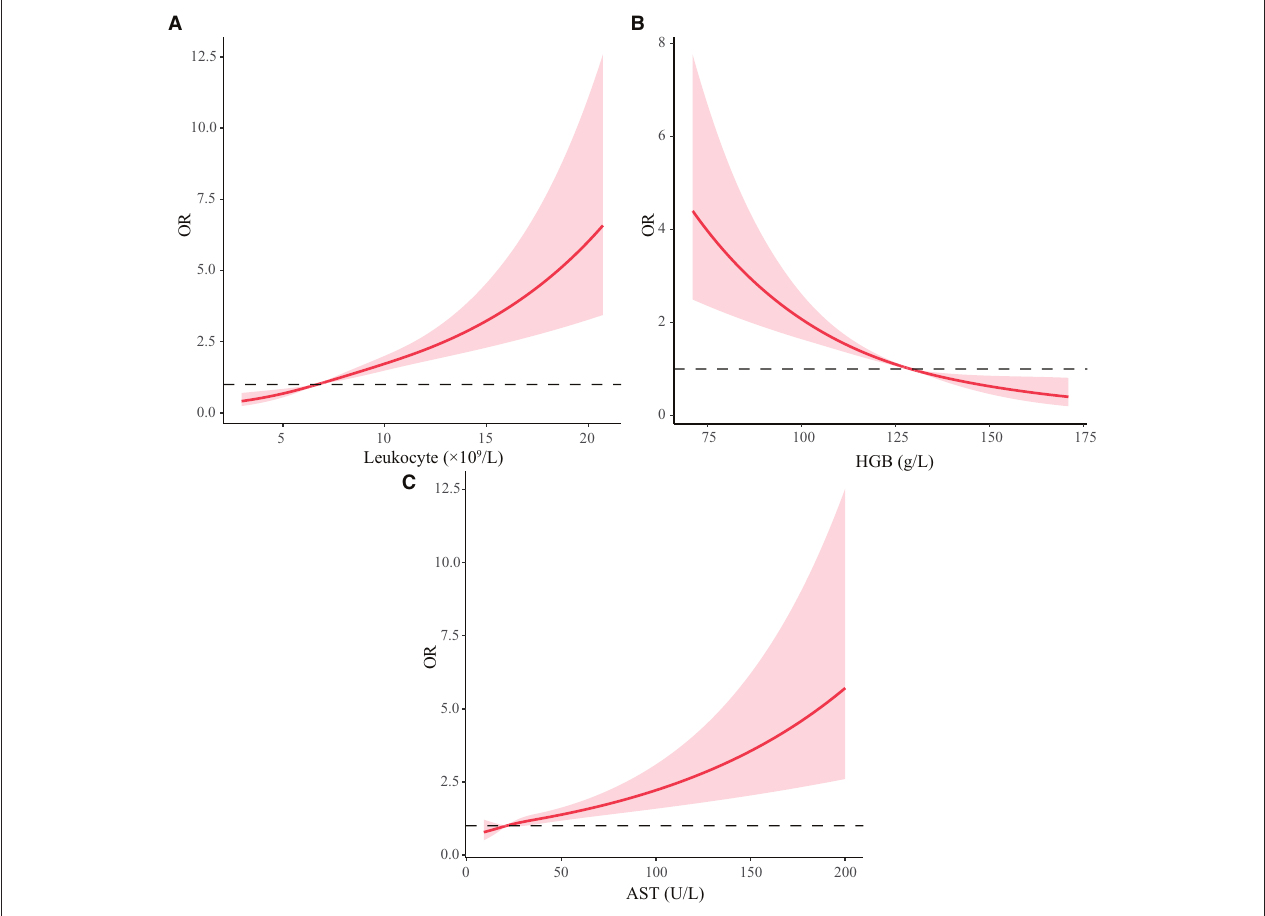
FIGURE 3 | Restricted cubic spline curve of continuous variables. HGB, hemoglobin; AST, aspartate aminotransferase; ALT, alanine aminotransferase. (A-C) Represents the changing trend of risk of MACEs with leukocyte, HGB, and AST.